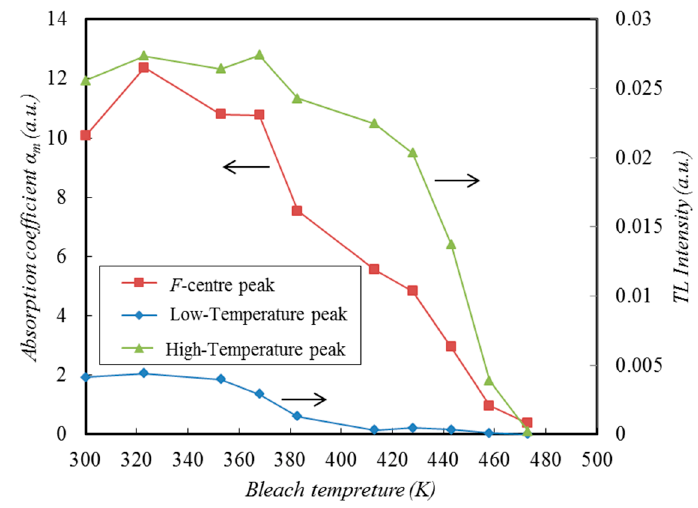
Figure 11. Variations of F -centre peak in absorption spectrum and each peak of TL glow curve with thermal-bleach temperature for X-ray irradiated (irradiation time: 10 min) KCl:Eu 2+ (0.02 mol%) single crystals.